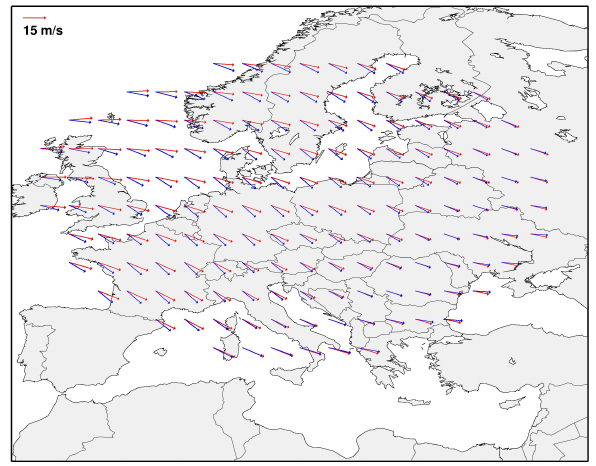
Fig. 9. Wind vectors representing average conditions at 300hPa in JFM during solar maxima (red arrows) and solar minima (blue ar- rows) over Europe. The length of the arrows is linearly proportional to the wind speed. Data are from REC2